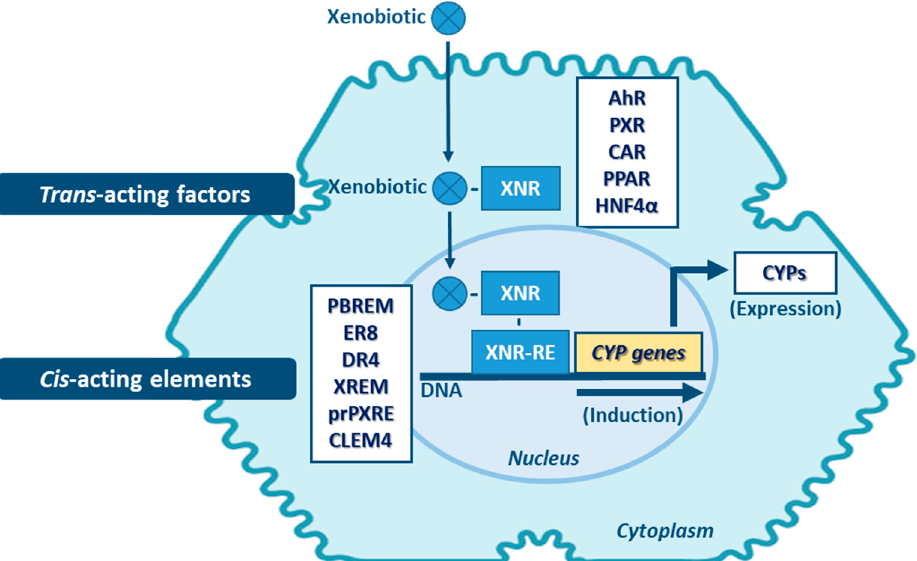
Figure 5. Main mechanisms of CYP induction. AhR: aryl hydrocarbon receptor; CAR: constitutive androstane receptor; CLEM4: constitutive liver enhancer module 4; DR4: direct repeat 4; ER8: estrogen receptor 8; HNF4 α : hepatocyte nuclear factor 4 α ; PBREM: phenobarbital-responsive enhancer module; PPAR: proliferator-activated receptor; prPXRE: proximal PXR responsive element; PXR: pregnane nuclear receptor; XNR: xenobiotic-nuclear receptors; XNR-RE: xenobiotic-nuclear receptors-responsive elements; XREM: xenobiotics-responsive enhancer module. (Note: other regulatory factors and elements not referred may be involved in CYP expression induction).